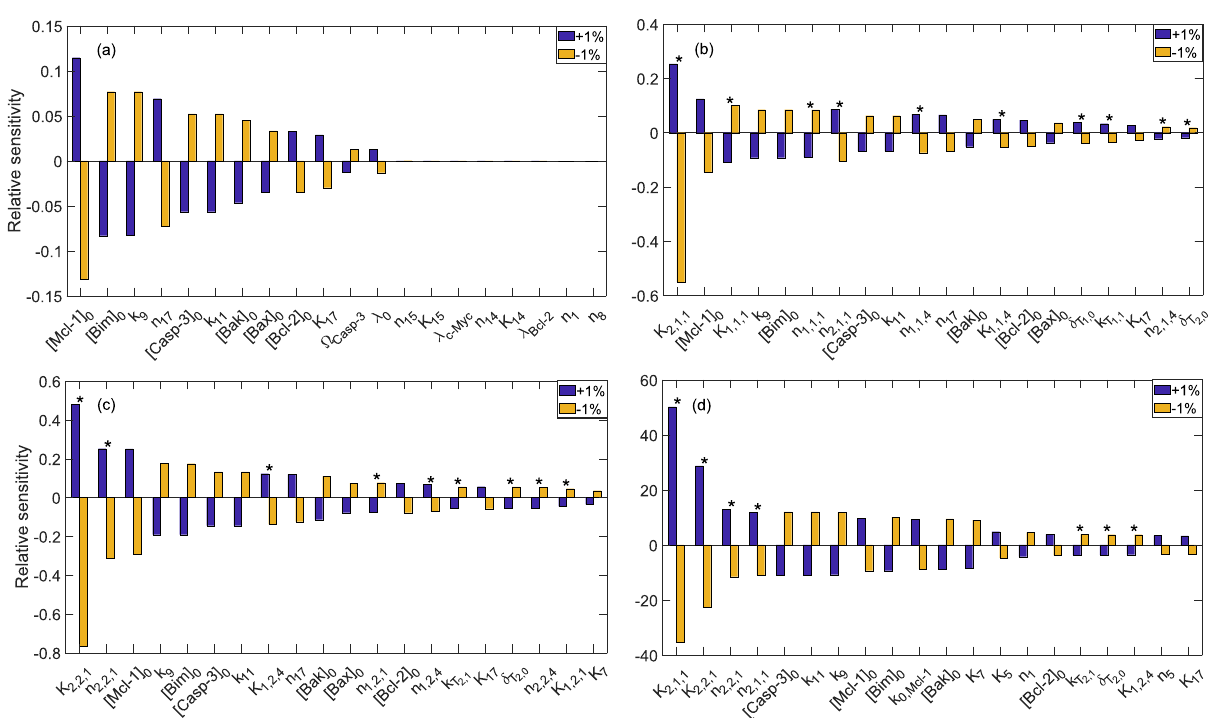
Fig 5. Results of local sensitivity analysis around the nominal parameter set for (a) the untreated system, (b) 400 nM venetoclax monotherapy, (c) 5,000 nM tedizolid monotherapy, and (d) 400 nM venetoclax and 5,000 nM tedizolid combination therapy. Plots show the relative sensitivity calculated using Eq (2) resulting from perturbations of ± 1% to individual kinetic parameters or initial conditions in each treatment case. Top 20 kinetic parameters/ initial conditions are shown in each plot. Asterisks denote kinetic parameters that affect the expression of the transcription factors c-Myc and Chop (see Ref.